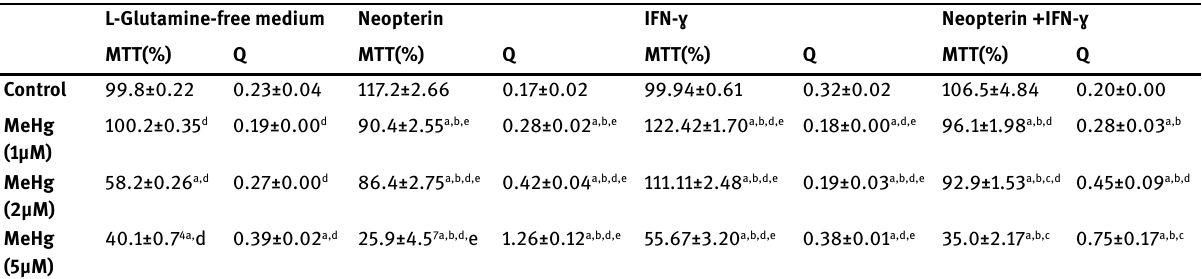
Tables 4: Total mitochondrial metabolic activity and oxidative stress coefficient of MetHg-exposed SH-SY5Y human neuroblastoma cell line in glutamine-free medium at the end of the 48-hour period. ( IFN- ɣ : Interferon-gamma; MetHg: Methyl mecury; MTT: Cell viability; Q:[(NOx/Cc )/(MTT/Cc)], oxidative stress coefficient